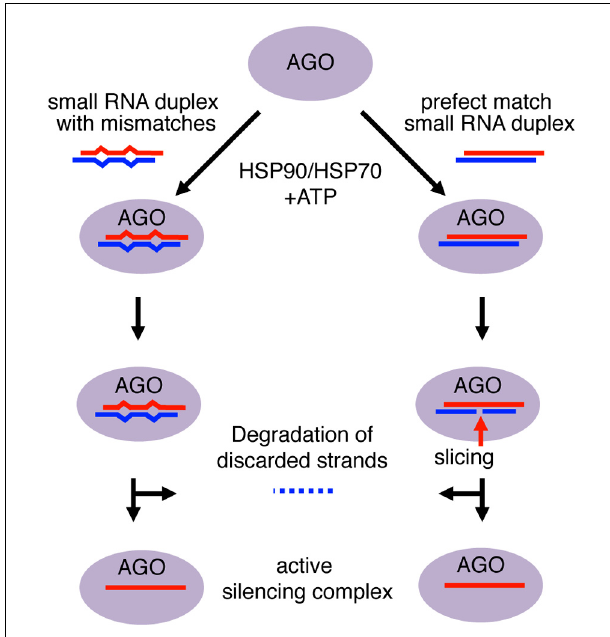
FIGURE 1 | Mechanism of small RNA duplex loading intoArgonaute proteins. Loading of Argonaute (AGO) with RNA duplexes involves a conformational change in AGO that requires chaperones and ATP.The 5 (cid:3) end of the guide strand is anchored to the MID domain, while the 3 (cid:3) end is bound within the PAZ domain.The passenger strand is left unanchored. In small RNA duplexes with mismatches, the energy from the conformational change is used to slowly unwind the duplex and discard the passenger strand.The AGO returns to a close conformation with the guide strand as an active silencing complex. In perfect RNA duplexes, the passenger strand would be sliced in catalytically active AGO and degraded by endonucleases. In contrast, mismatched duplexes would be unwound and the passenger strand would be discarded for subsequent